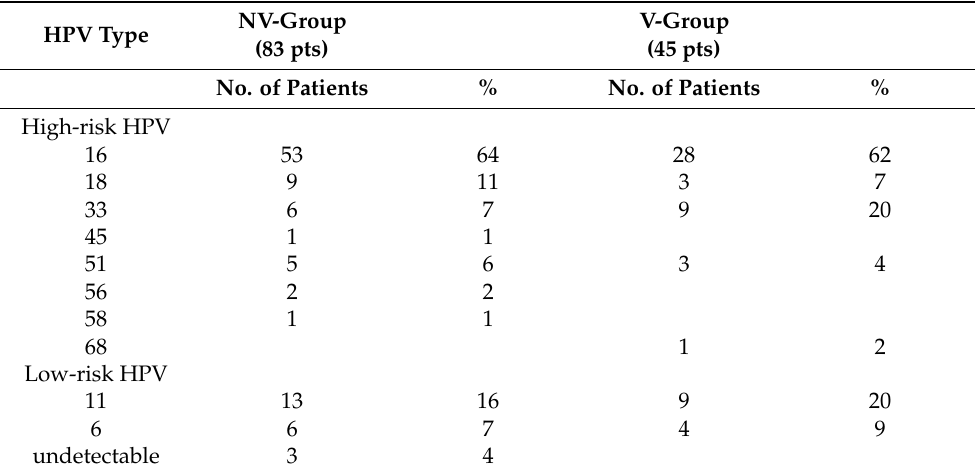
Table 2. HPV types of distribution identified at